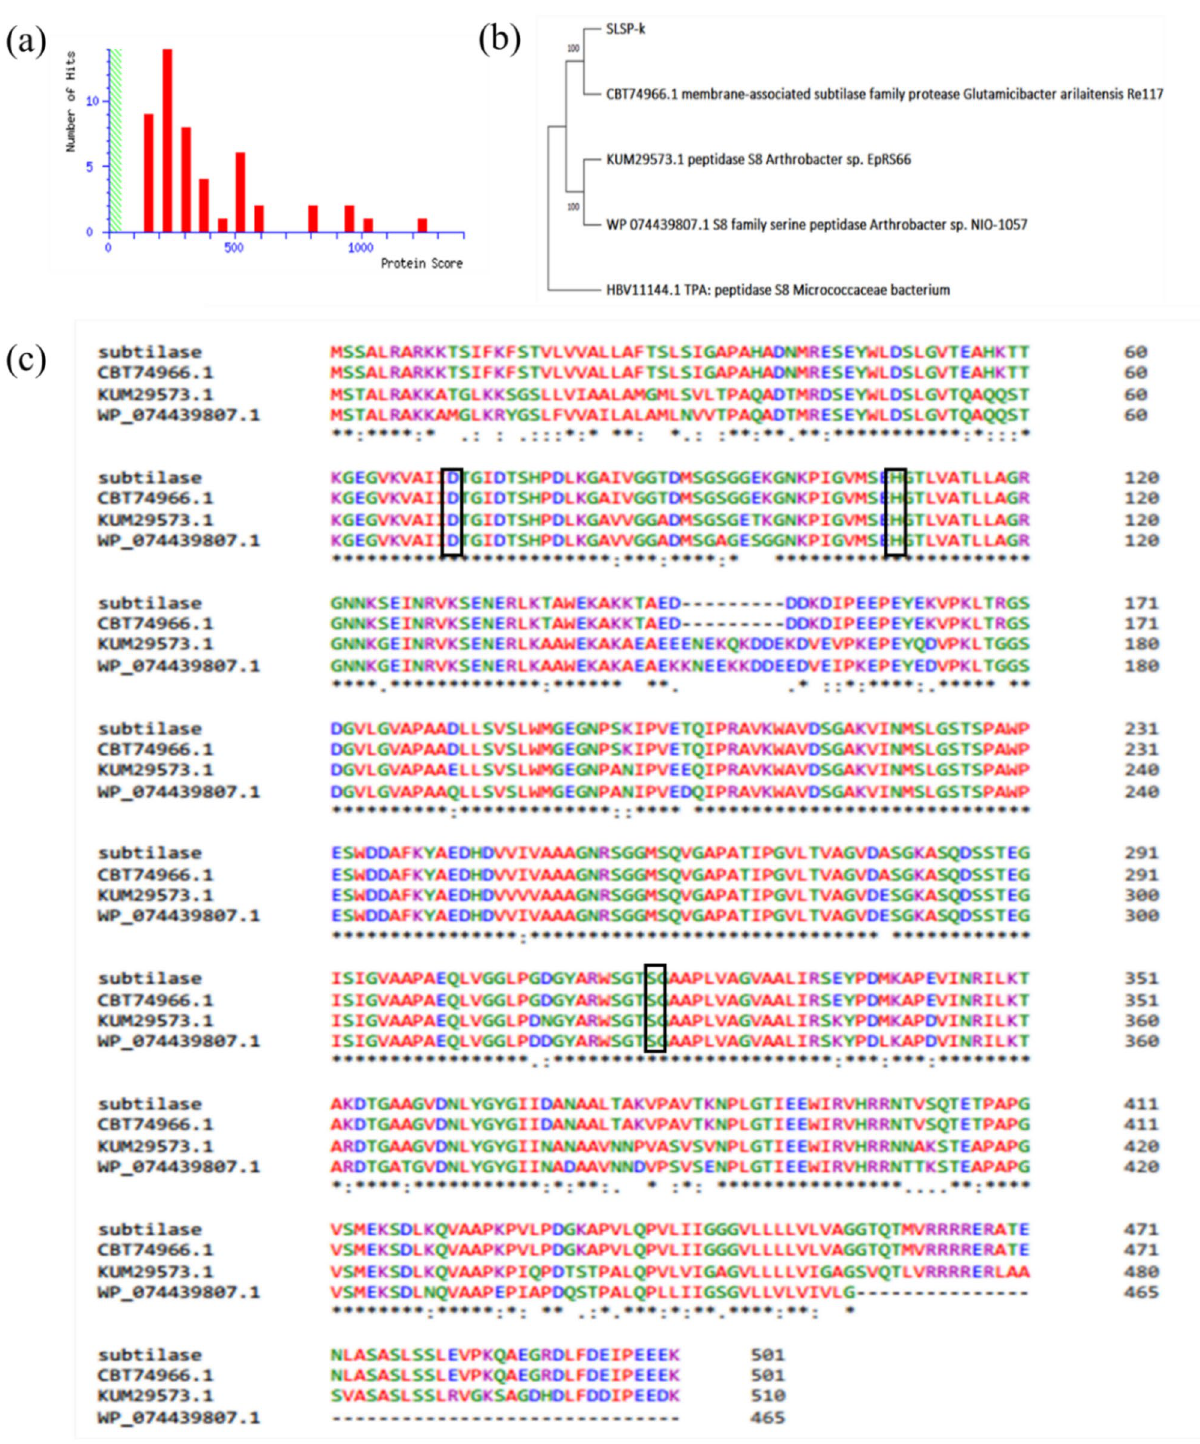
Figure 2. ( a ) Mascot Score Histogram, ( b ) Phylogenetic tree constructed using amino acid sequence of subtilisin like serine protease by Mega X software, ( c ) Homologous sequence alignment of protease using Clustal omega program. The catalytic triad is marked with black